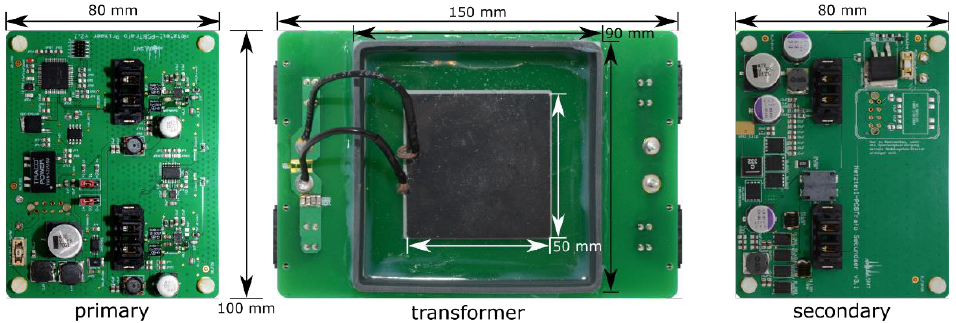
Figure 6. Individual components of the isolated DC power supply (primary side on the left, secondary side on the right, and transformer in the middle). Overall system size 31 cm × 10 cm × 4 cm giving a volume of 1240 cm³. The transformers have a size of 15 cm × 10 cm × 4 cm giving a volume of 600 cm 3 and a weight of 480 g.